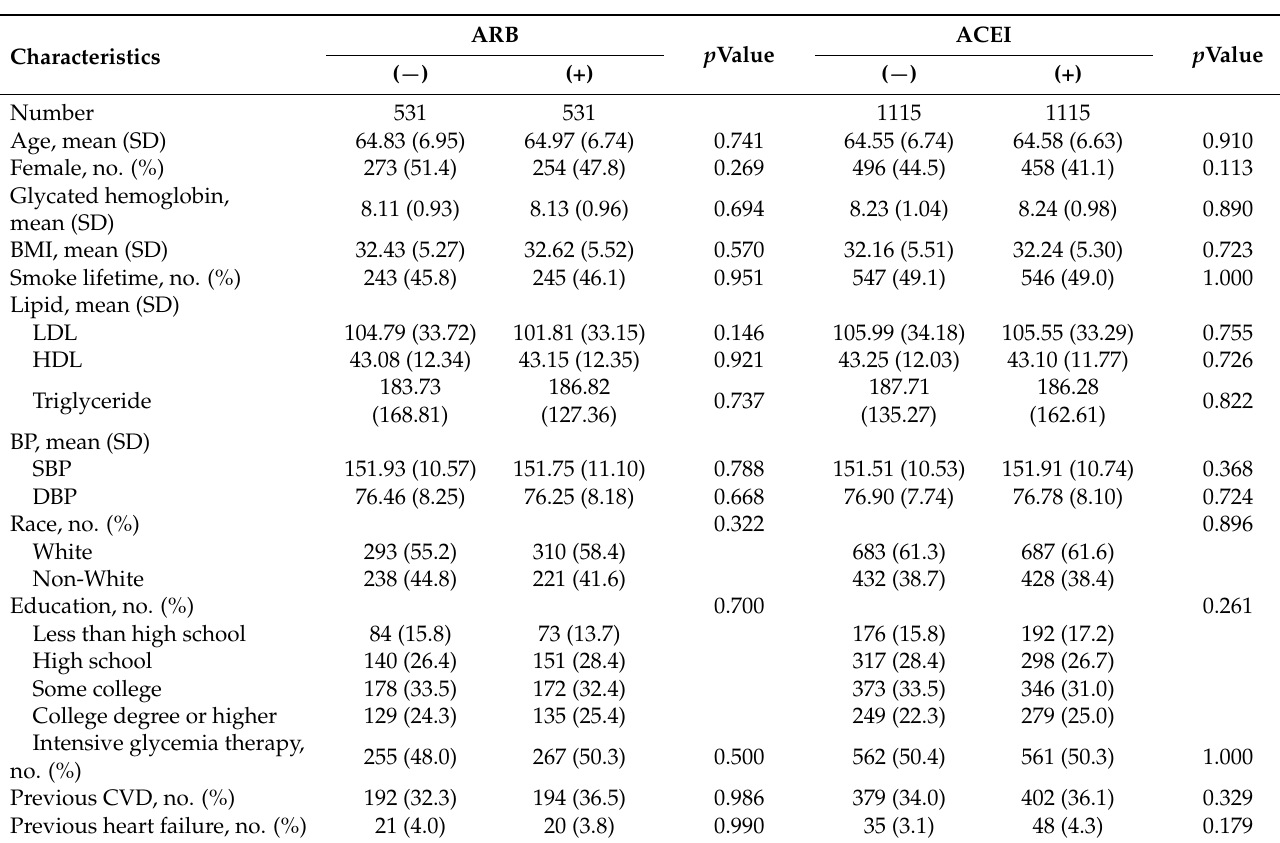
Table 1. Baseline characteristics of propensity score-matched patients with antihypertensive therapy and